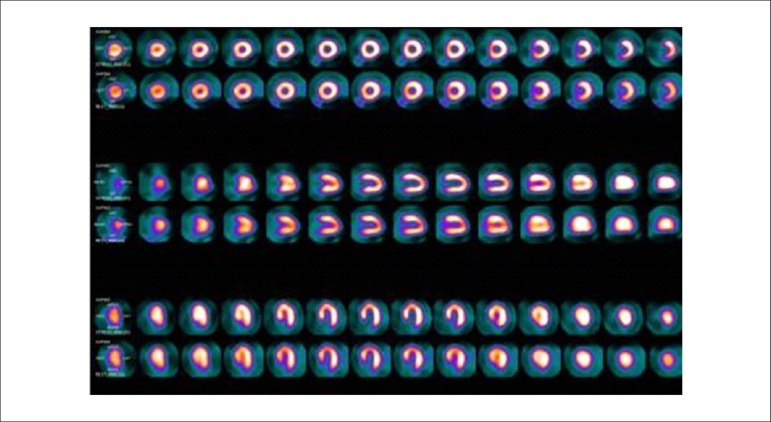
Case 1 - Myocardial perfusion scintigraphy within normality. Images acquired with dedicated cardiac equipment (gamma camera), equipped with solid cadmium-zinc-tellurium detectors.